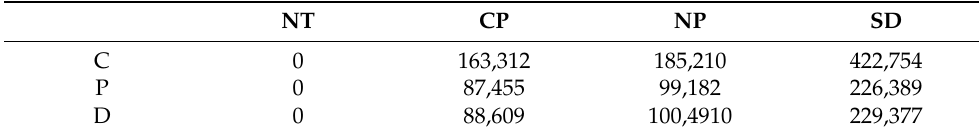
Table 8. Carbon credit cost for diesel engine-powered ships, ( €